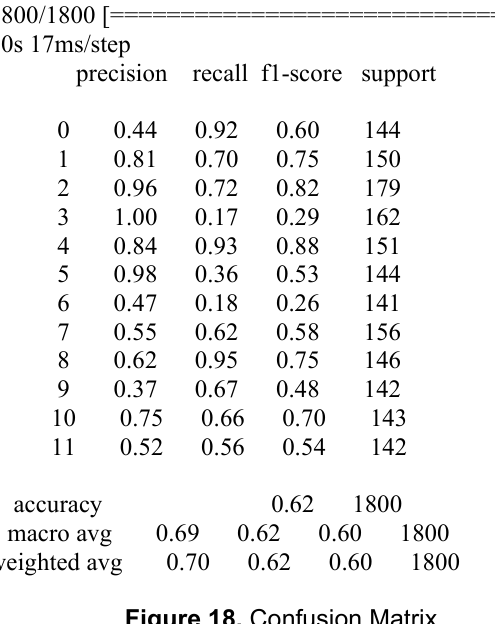
Figure 18. Confusion